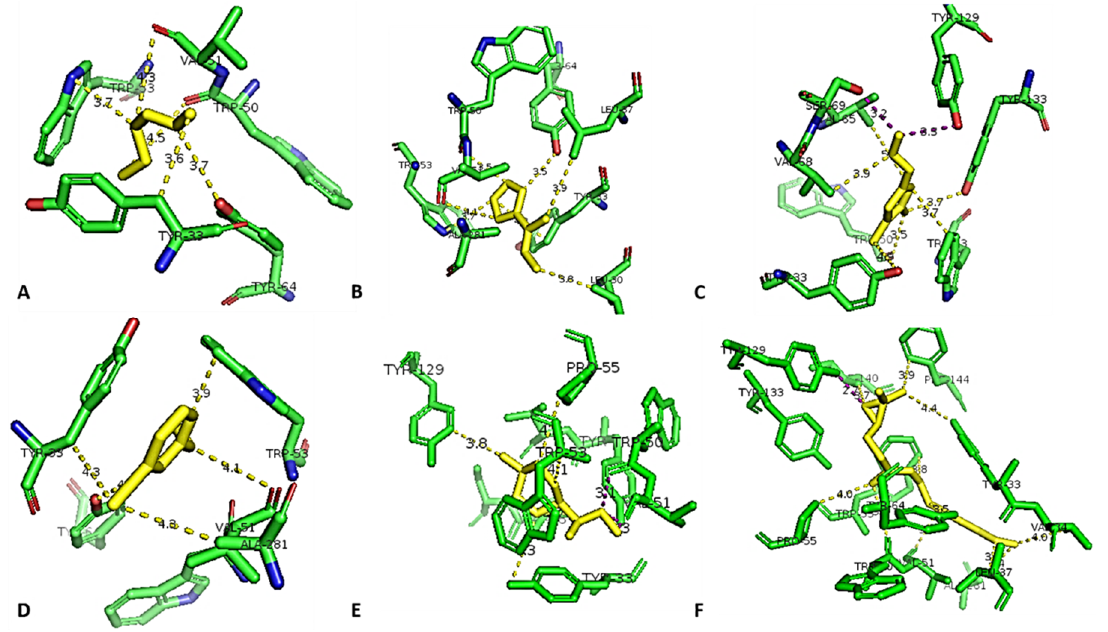
Figure 6. Interaction of selected molecules, in yellow, with the amino acid residues, in green, of the macromolecule 5V13 (juvenile hormone), in green. ( A ) M01 (ZINC13514543); ( B ) M02 (ZINC14413017); ( C ) M03 (ZINC05680928); ( D ) M04 (ZINC04691148); ( E ) M05 (ZINC95851150); ( F ) JH3